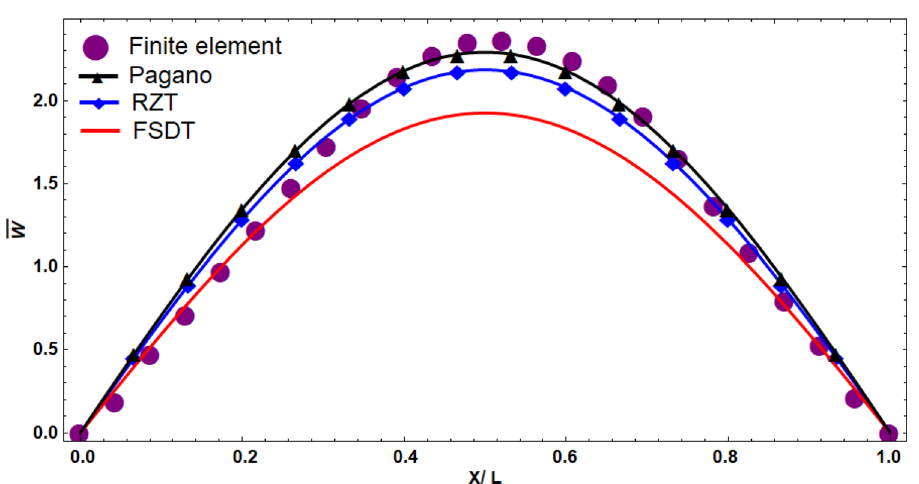
Figure 3. The comparison of the normalized vertical deformation calculated using different theories at y =